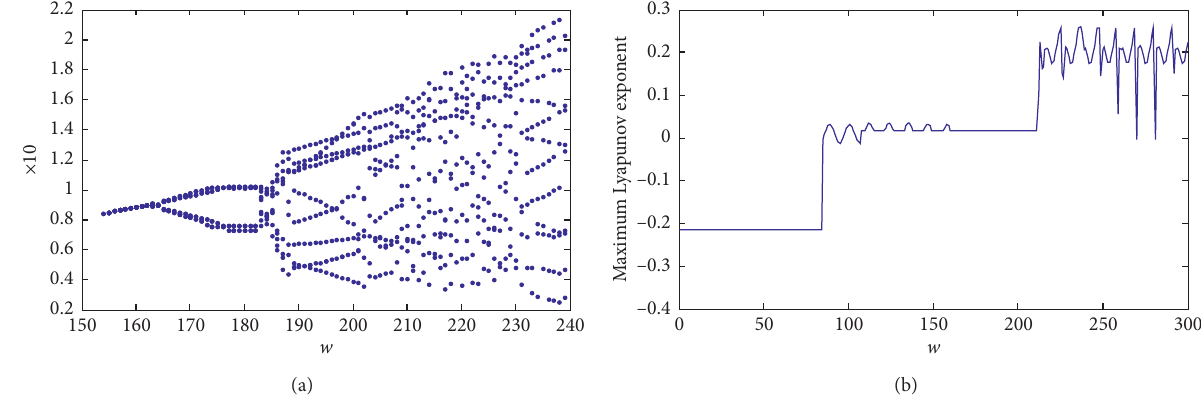
Figure 22: (a) Vibrational bifurcation diagram with the Coulomb model when t ∈ 0 . 05 0 . 0581 􏼂 􏼃 . (b) Maximum Lyapunov exponent curve with the Coulomb model when t ∈ [0.05